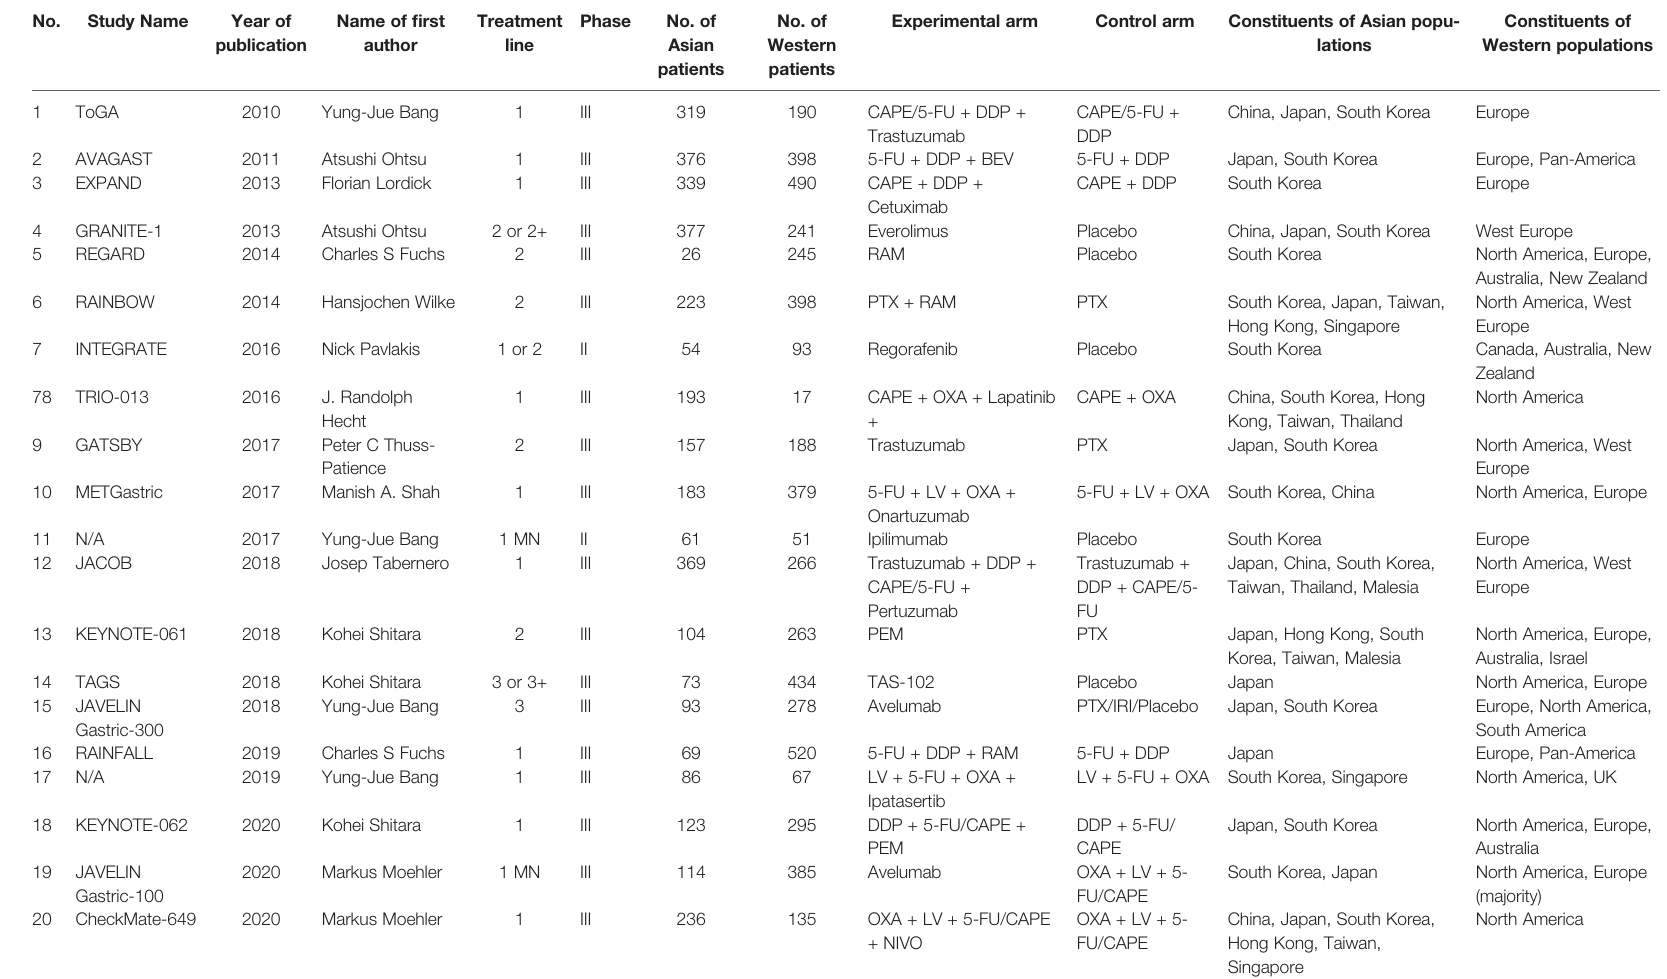
TABLE 1 | Major characteristics of the eligible